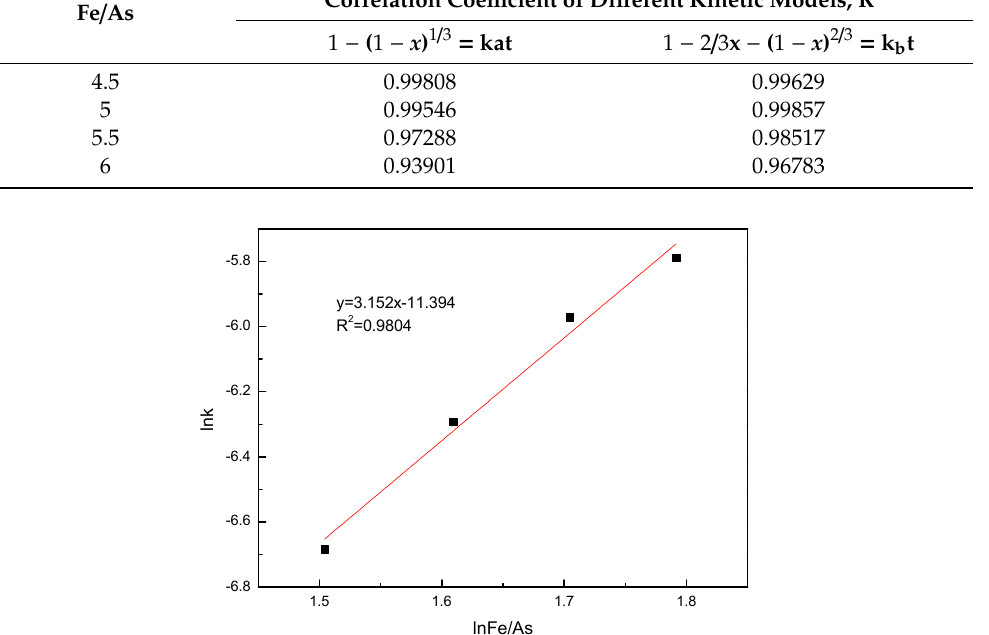
Figure 8. Arsenic removal kinetics at different molar ratios of iron to arsenic. Table 3. Correlation coefficient (R 2 ) values for the different the molar ratios of iron to arsenic and kinetic data. Fe / As